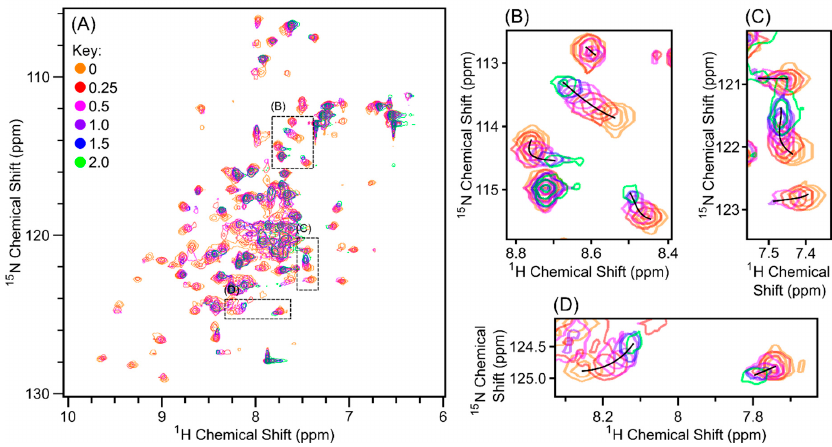
Figure 5. Overlay of 1 H, 15 N-HSQC spectra of 15 N-Scc4 titrated with Scc1-FLAG. Relative moles of Scc1-FLAG to 15 N-Scc4 added are 0 (orange), 0.25 (red), 0.5 (pink), 1.0 (purple), 1.5 (blue), and 2.0 (green). ( A ) The full spectra overlaid with boxes showing the expanded regions. ( B – D ) The expanded regions of the overlaid spectra in ( A ) with black lines marking the chemical shift perturbation over the course of the titration. The spectra were collected on a Bruker AVIII 500 MHz spectrometer with 8 scans for each spectrum, with the exception of the spectrum at 2.0 relative moles (green), which was collected with 32 scans. The contour levels were corrected for the number of scans to allow for direct comparison. Individual spectra are shown in Figure